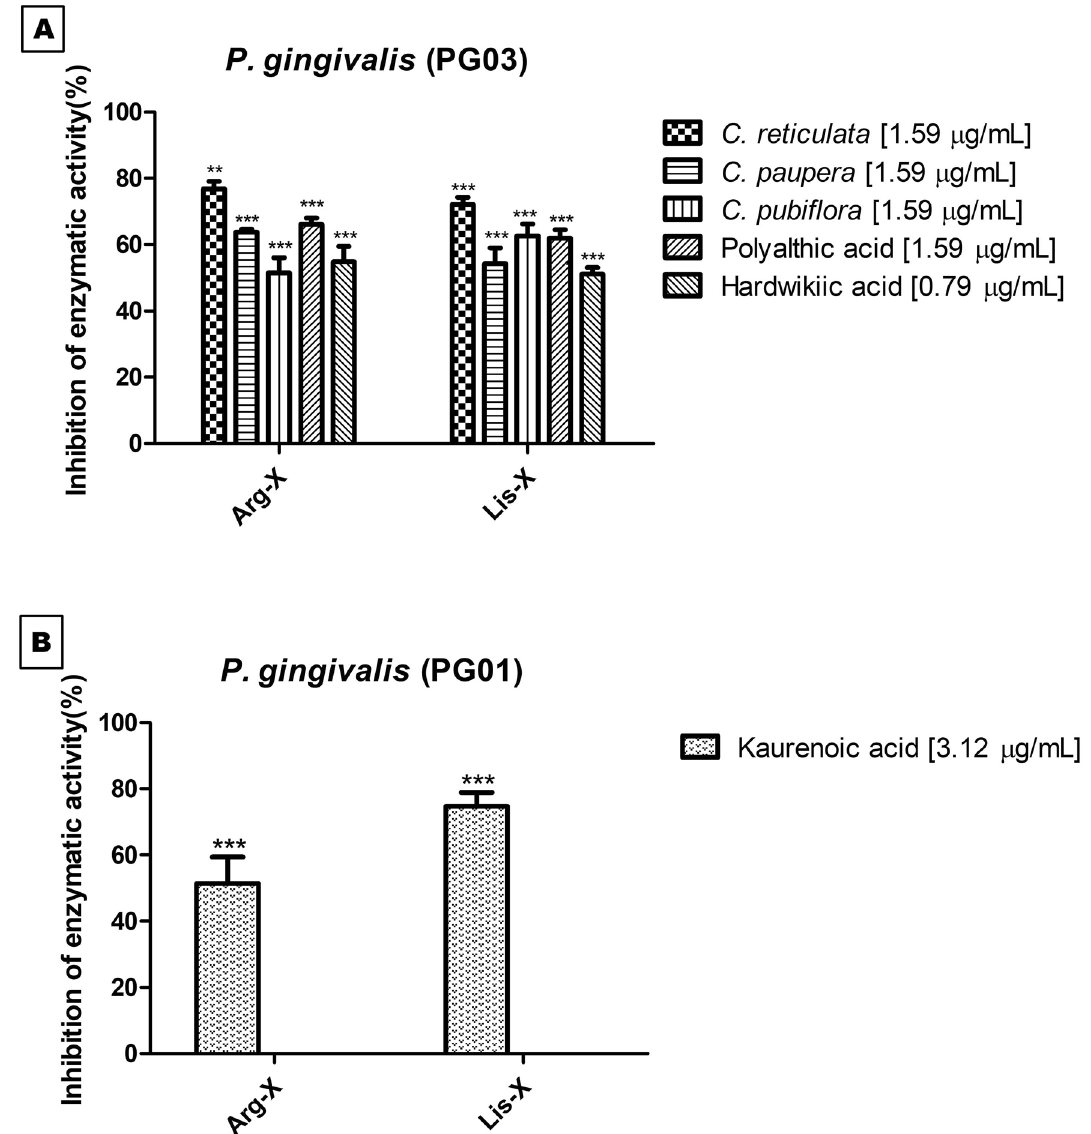
Figure 4. Inhibition of the Arg-X and Lys-X enzymatic activity (%) by the C. reticulata, C. paupera, and C. pubiflora oleoresins ( A ) and the isolated compounds kaurenoic acid ( B ), polyalthic acid, and hardwickiic acid ( A ). Values are expressed as mean and standard deviation in triplicate. Double asterisks ( P < 0.01) and triple asterisks ( P < 0.001) indicate significantly different values versus control values. Data were analyzed using GraphPad Prism software version 5.00 (available https ://www.graph pad.com/scien tific -softw are/prism